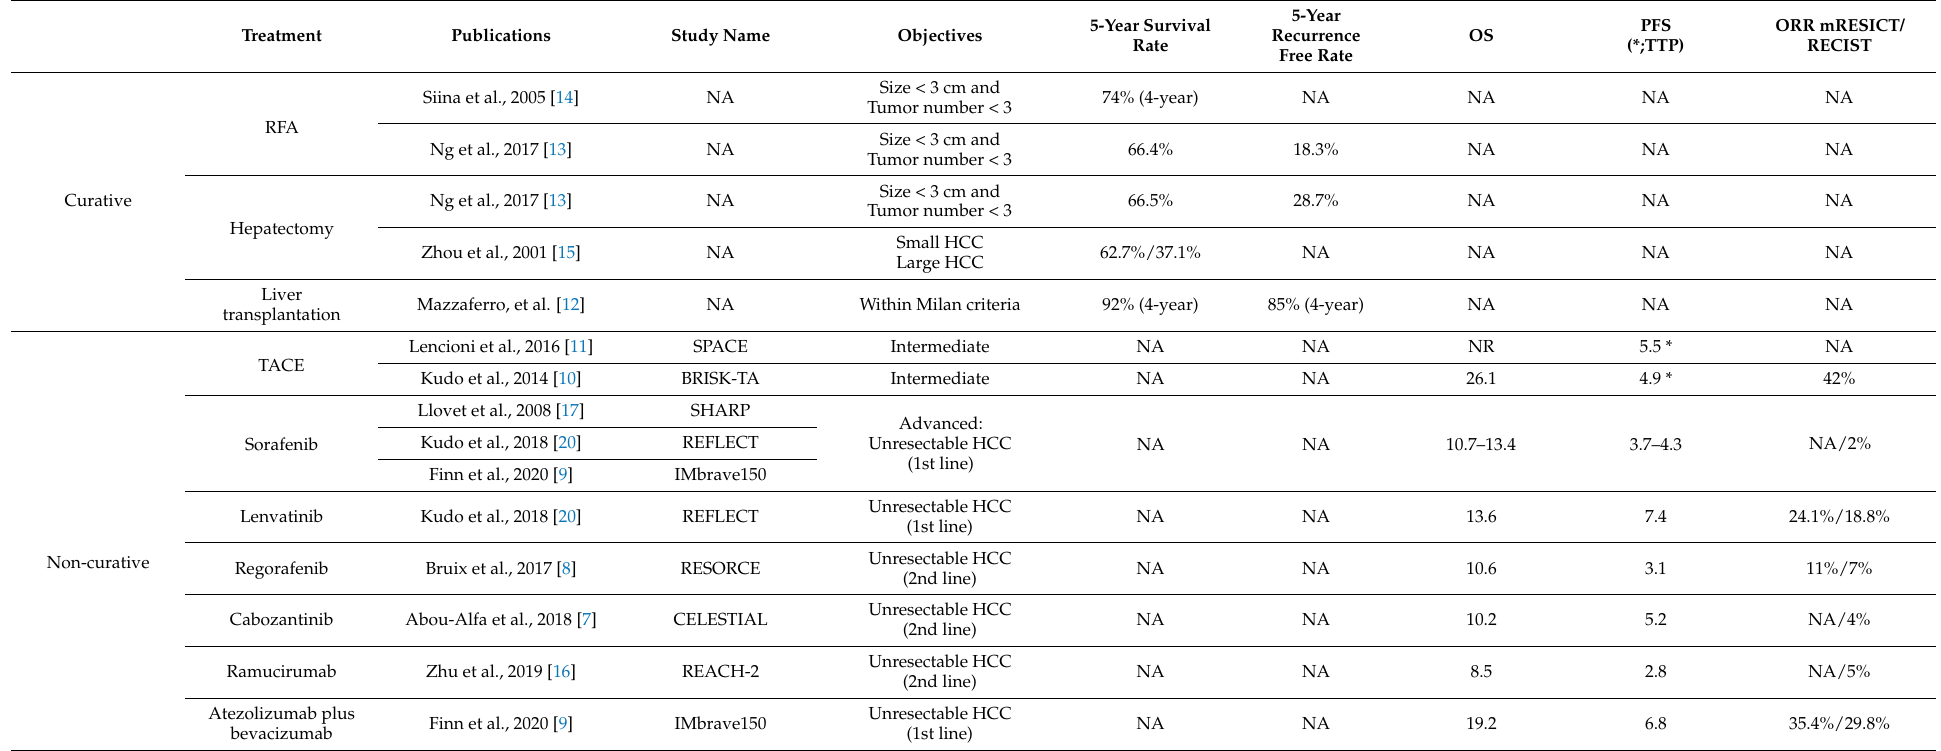
Table 1. Summary of treatment outcomes of recent treatment